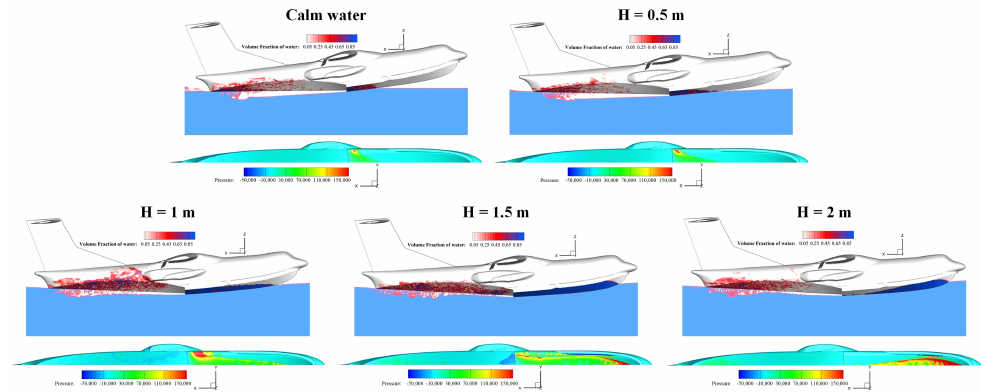
Figure 18. Comparison of free surface and pressure distribution of aircraft landing with different wave heights at t = 0.526 s.